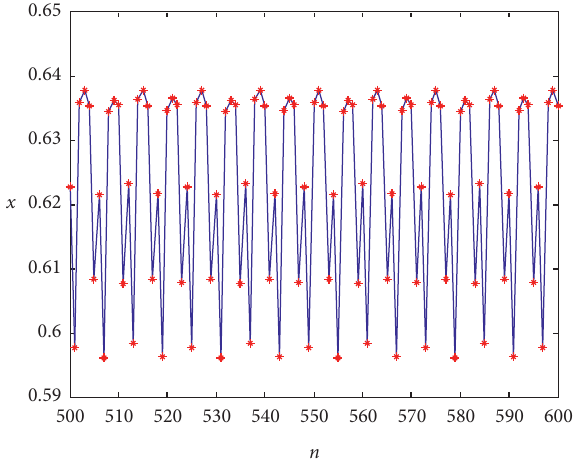
Figure 26: x - y phase diagram which denotes that the system is 8-fold periodic when c � 0.15.